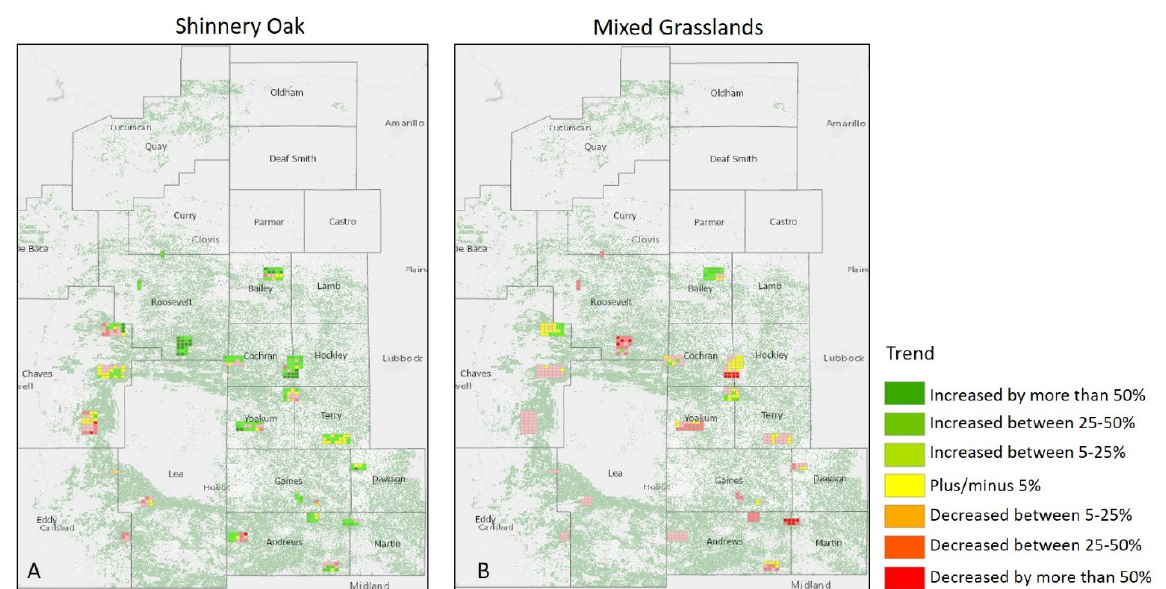
Figure 7. Spatial trends in landscape composition: ( A ) sand shinnery oak—dominated vs. ( B ) mixed grasslands) between the 1950s and 2015. This assessment combined data gathered from aerial photography interpretation in selected locations where aerial photos were available for the 1950s and 1970s over a 2.5 km × 2.5 km grid. Trends are shown as the total percentage change for each vegetation type from the 1950s to 2015.